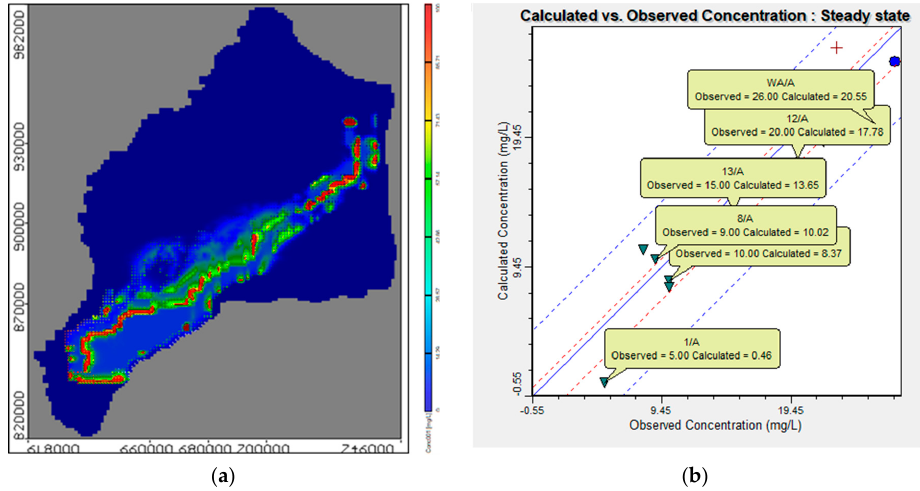
Figure 6. ( a ) Aerial view of COD distribution in the ENDA. ( b ) The difference between calculated and observed concentration.